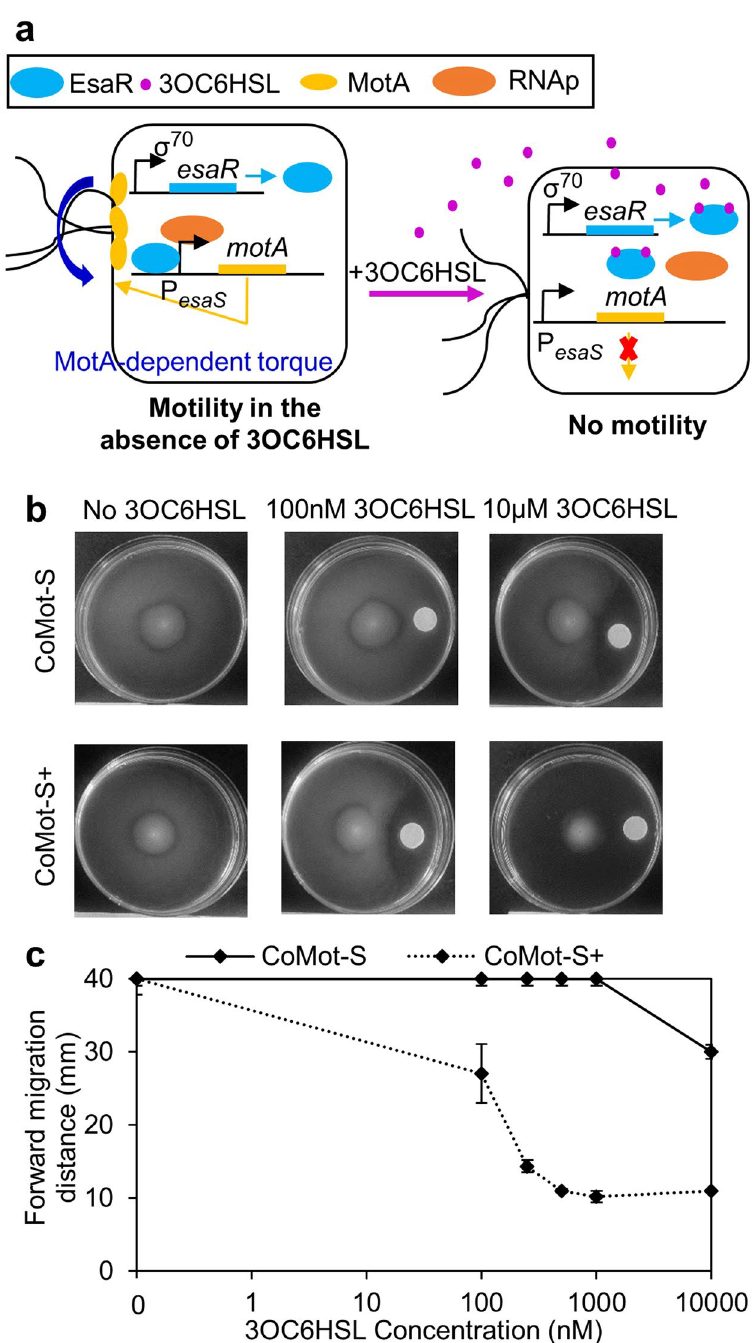
Figure 6. Characterization of the migration response of CoMot-S and CoMot-S + cells in a 3OC6HSL gradient shows directional movement of cells away from a 3OC6HSL source: ( a ) Illustration of 3OC6HSL-dependent motA expression in the CoMot-S strain. Expression of motA is under the control of the P esaS promoter. esaR is constitutively expressed from a σ 70 -dependent promoter and activates expression from P esaS . In the absence of 3OC6HSL, motA is expressed and motility is restored in the Δ motA cells. Following addition of 3OC6HSL, EsaR unbinds from P esaS . motA expression decreases and the cells become non-motile. ( b ) 3OC6HSL gradients were established by adding 0–53 μ g of 3OC6HSL on a Whatmann membrane and allowing it to diffuse for 8 h. 10 μ M of 3OC6HSL would be the final concentration if 53 µ g of 3OC6HSL diffused uniformly through the plate. CoMot-S ( Δ motA transformed with plasmids containing P esaS - motA and P σ 70 - esaR ) or CoMot-S + ( Δ motA transformed with plasmids containing P esaS - motA and P σ 70 - esaR-D91G ) cells were then inoculated at the centre of the plate. Representative plate images obtained after 24 h of incubation at 30 °C. ( c ) Forward migration distance was measured as the distance between the inoculation point and the visible edge of migration of cells up the signal gradient after 24 h of incubation at 30 °C. Error bars represent one standard deviation from the mean forward migration distance of three biological